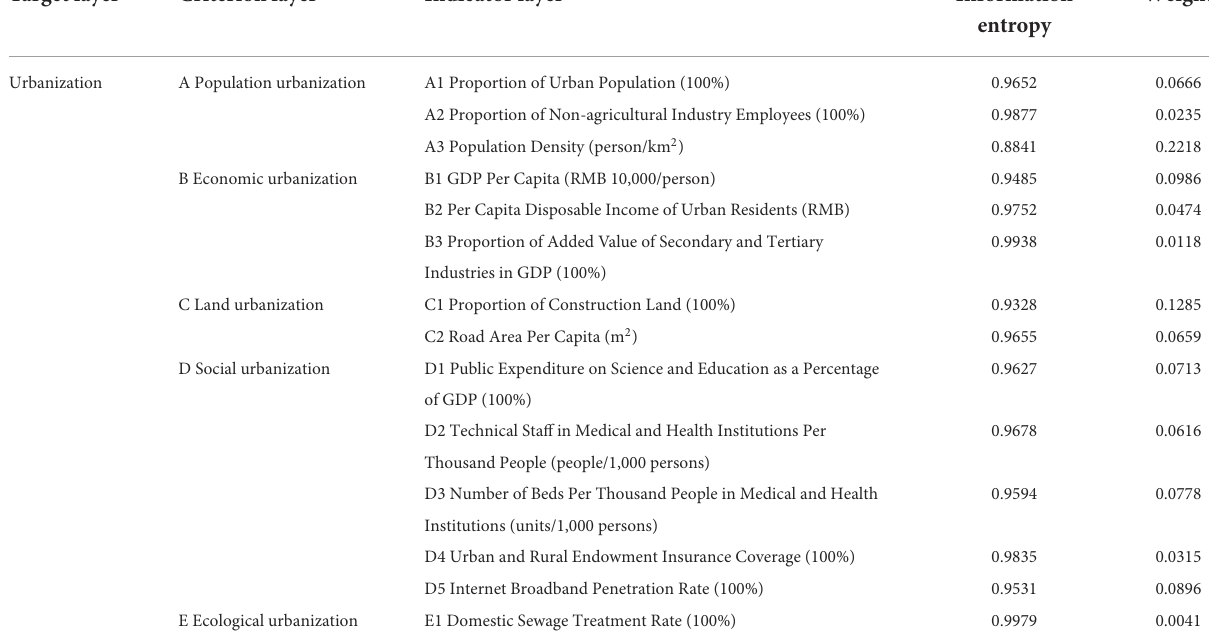
TABLE 1 Index system for measuring county urbanization